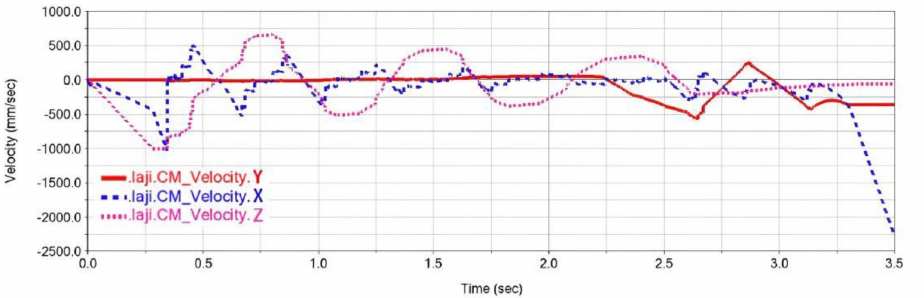
Figure 16. Comparison of the sub-velocity curves of the garbage along with the x, y, and z directions. The sub-velocity of the garbage along the y-axis is stable before the sorting device performs the dumping action, and there is a small deviation around v y = 0. The sub-velocity curve of the garbage along with the x-axis and z-axis assumes a wave